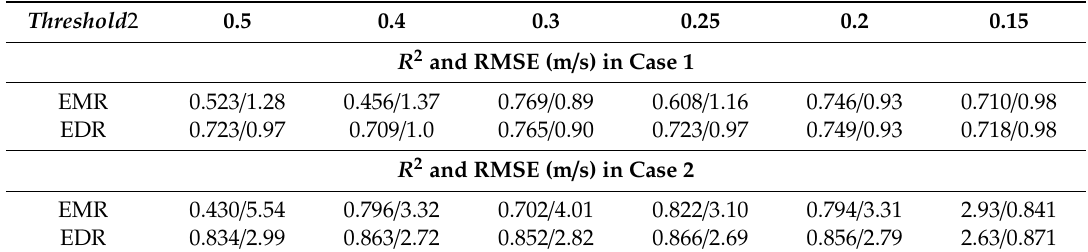
Table 5. Wind speed retrieval performances under different threshold values. Case 1: In the gentle wind scenario. Case 2: In the high wind scenario.